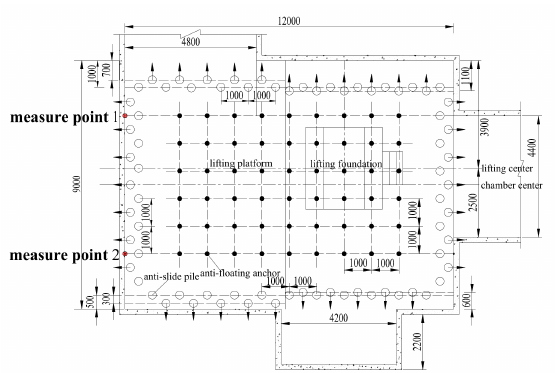
Figure 6. Layout of measure points.